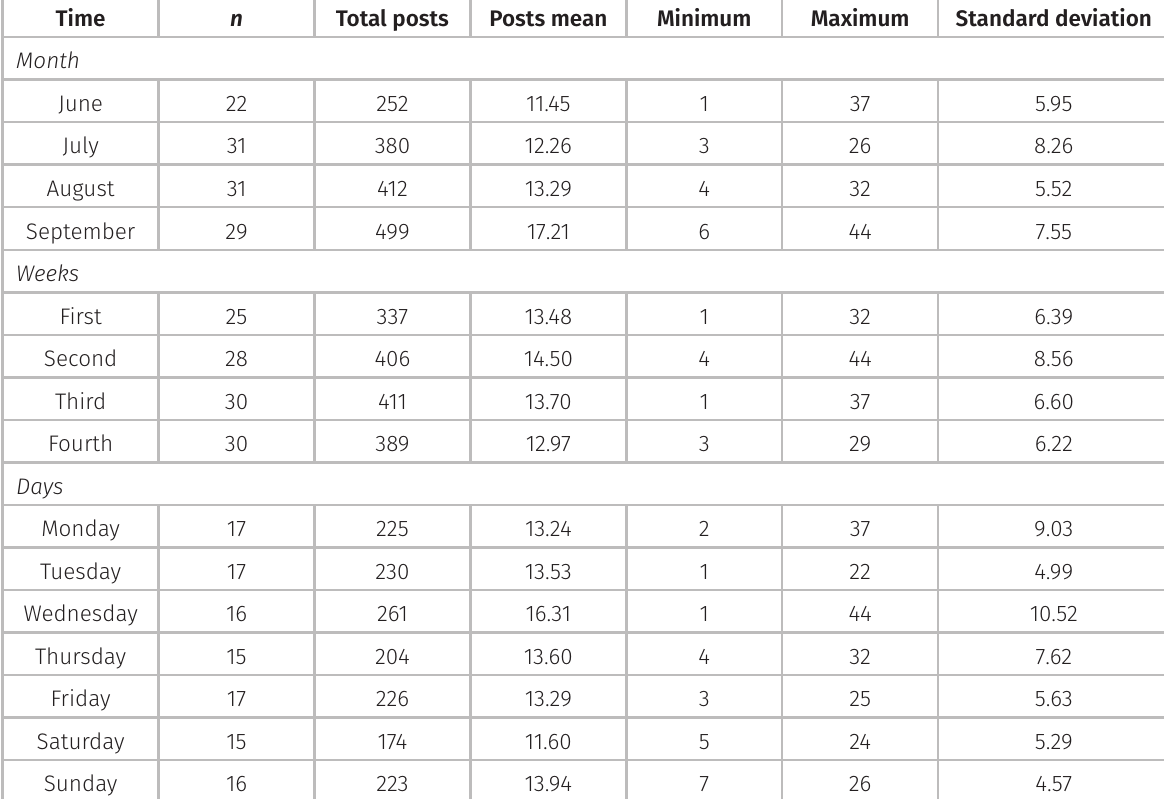
Table III. Descriptive statistics of the social media data retrieved monthly, weekly, and daily through the manual searches in